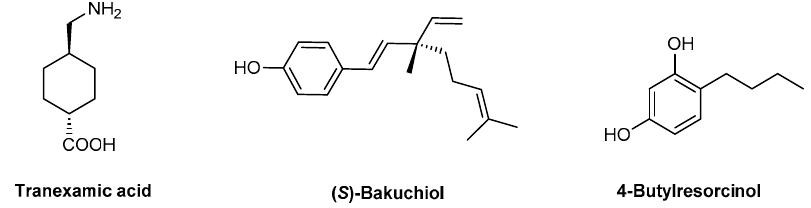
Figure 3. Structures of tranexamic acid, (S)-bakuchiol, and 4-butylresorcinol.